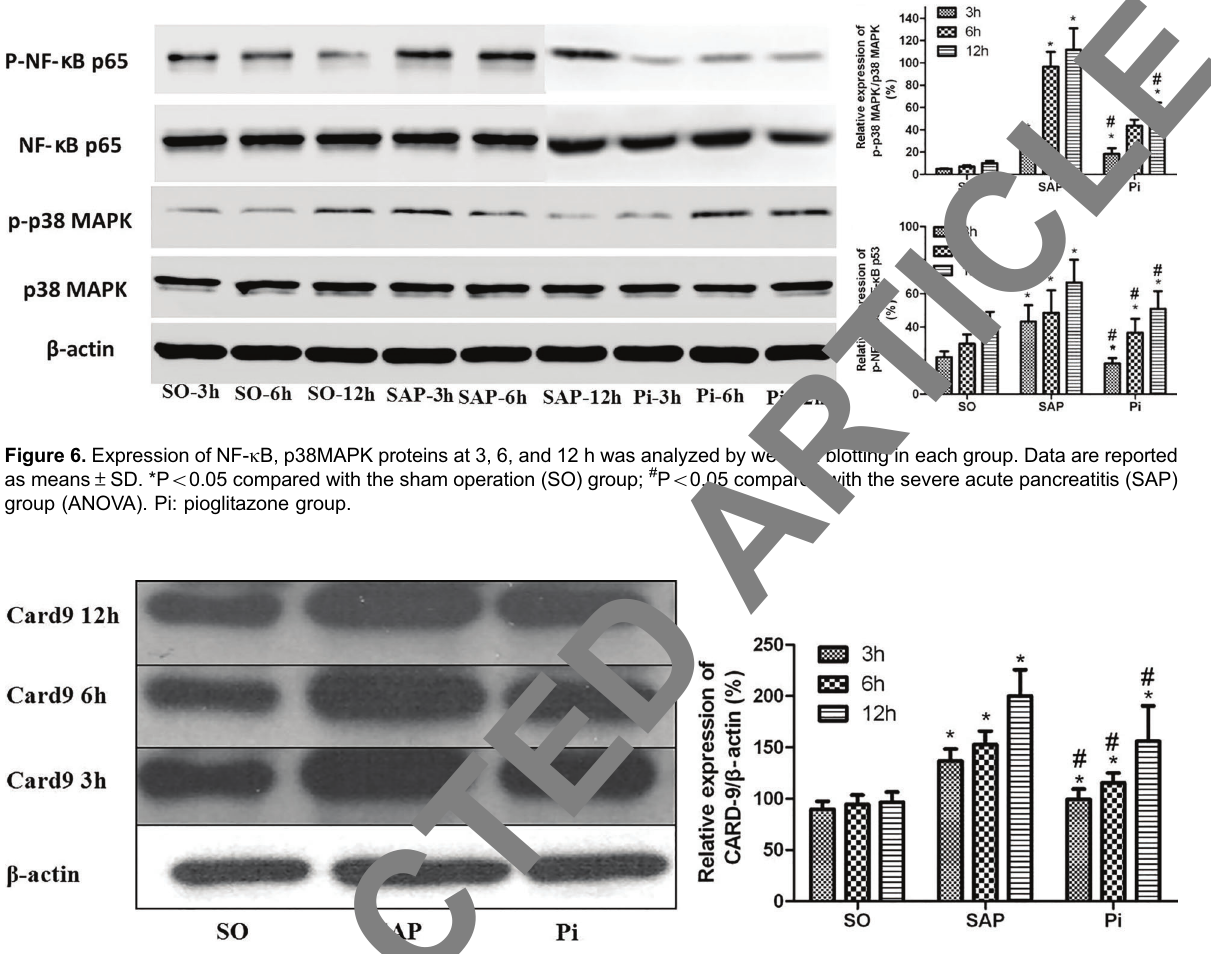
Figure 7. Expression of Card9 proteins at 3, 6, and 12 h was analyzed by western blotting in each group. Data are reported as means ± SD. *P o 0.05 compared with the sham operation (SO) group; # P o 0.05 compared with the severe acute pancreatitis (SAP) group (ANOVA). Pi: pioglitazone